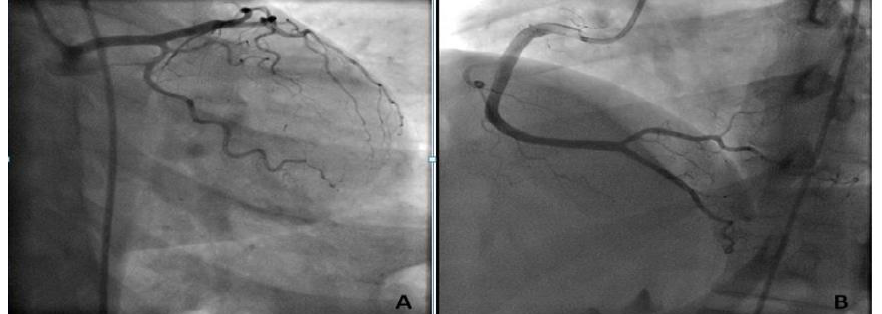
Figure 2. Selective coronary angiograms of left (a) and right (b) coronary arteries showing irregular luminal border of right coronary